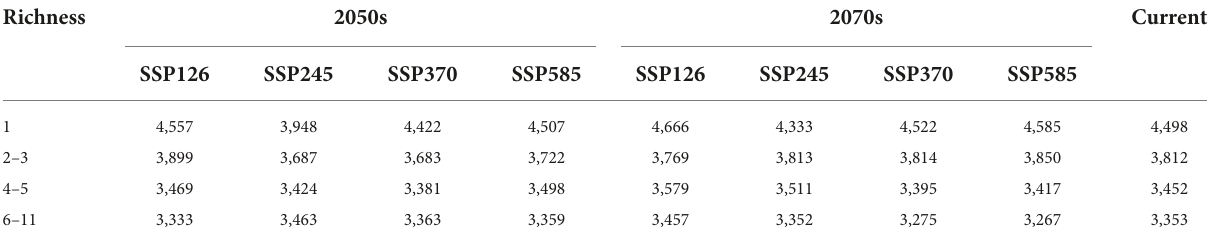
TABLE 6 The mean elevation (m) of orchid species richness under different climate